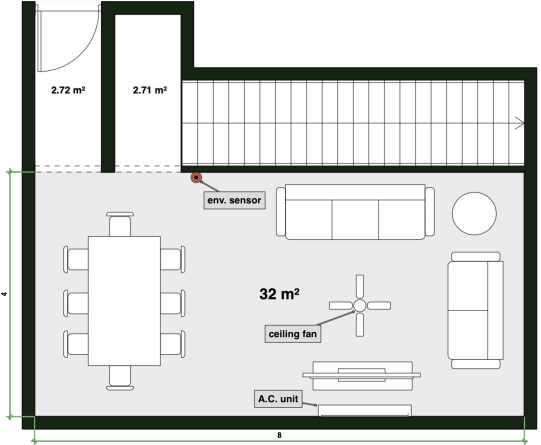
Figure 2. Sketch of the living room. The locations of the environmental sensor, ceiling fan, and AC unit are shown. The monitored area is approximately 32 m 2